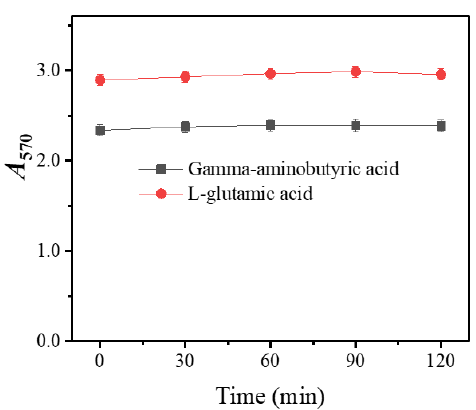
Figure 7. Stability of ninhydrin-based chromophore of gamma-aminobutyric acid or L-glutamic acid. A 570 : absorbance at 570 nm .